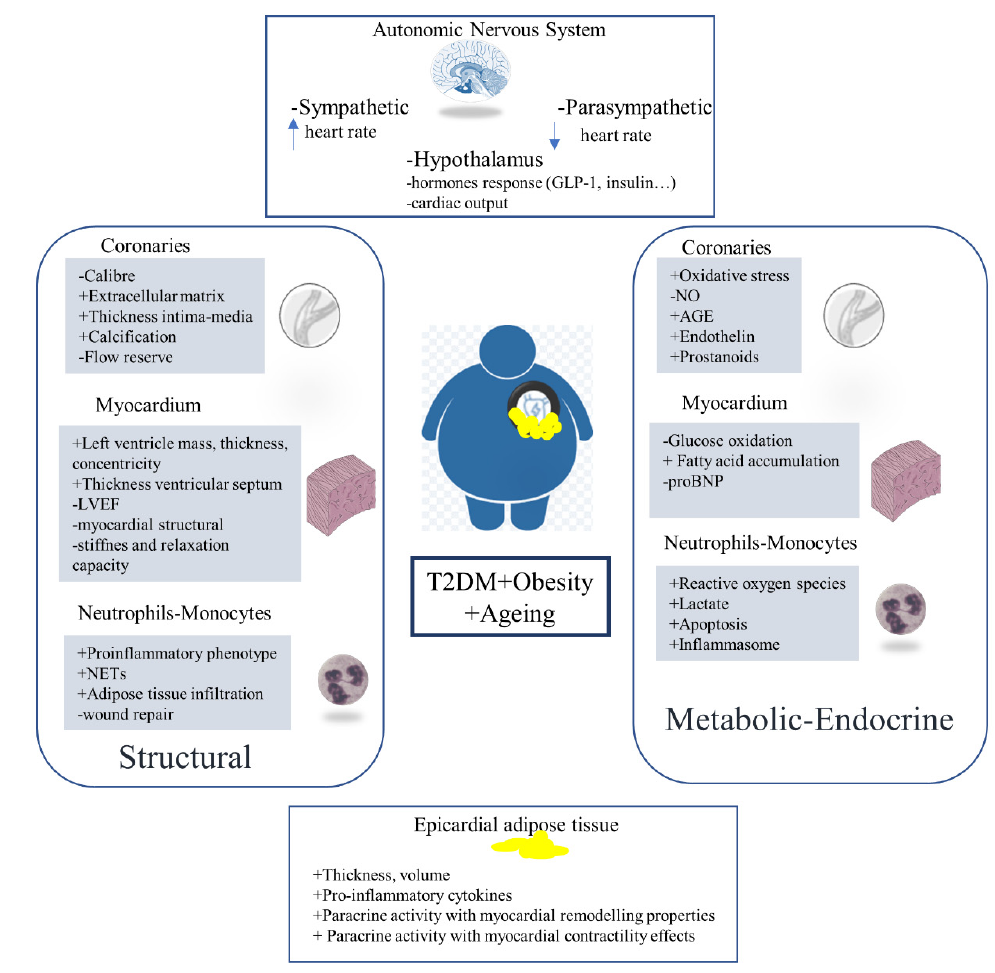
Figure 2. Structural, metabolic-endocrine and adiposity changes in T2DM, Obesity and